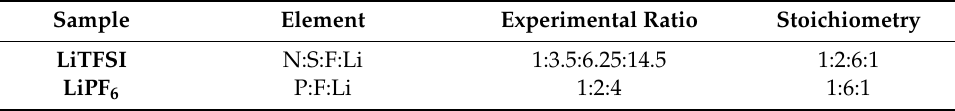
Table 4. Elemental ratios of electrolyte components in LiTFSI and LiPF